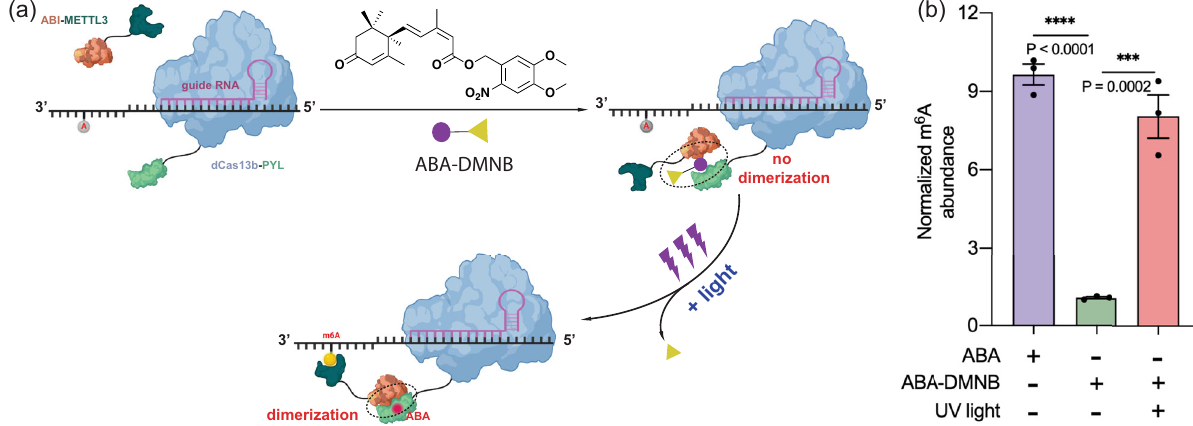
Fig. 5 Light-induced m 6 A writing at the Actb mRNA A1216 site in HEK293T cells. a The light-inducible m 6 A writing system incorporated photo-caged ABA-DMNB that can only be activated by UV light to regenerate functional ABA, which recruits ABI-M3 to enable m 6 A writing. b The relative m 6 A levels at the Actb mRNA A1216 site were edited by the inducible m 6 A writing system using ABA or ABA-DMNB with or without light irradiation. All results of groups with different treatments were normalized to the group of dCas13b-PYL with gRNA-2 and ABA treatment. Values and error bars re fl ect the mean, s.e.m. of three independent biological replicates. P values shown in the charts are determined by one-way ANOVA. Source data are provided as a Source Data fi